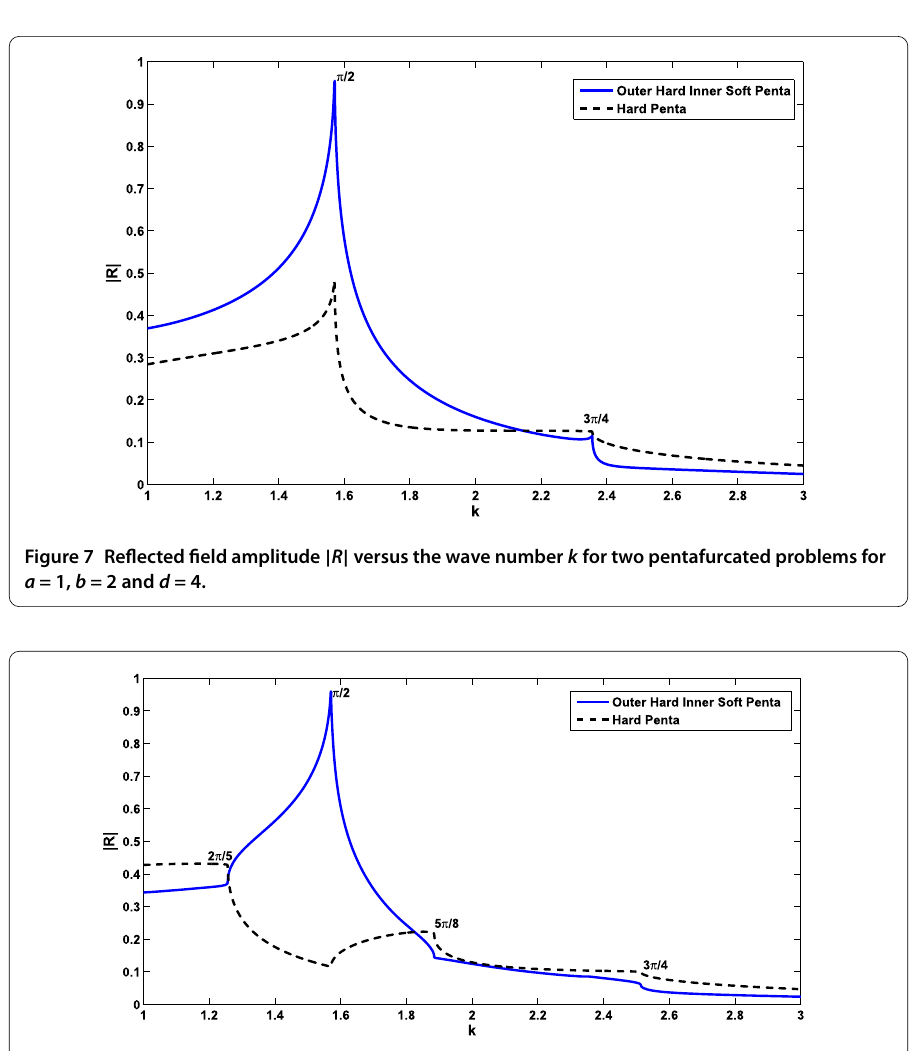
Figure 8 Reflected field amplitude | R | versus the wave number k for two pentafurcated problems for a = 1, b = 3 and d =